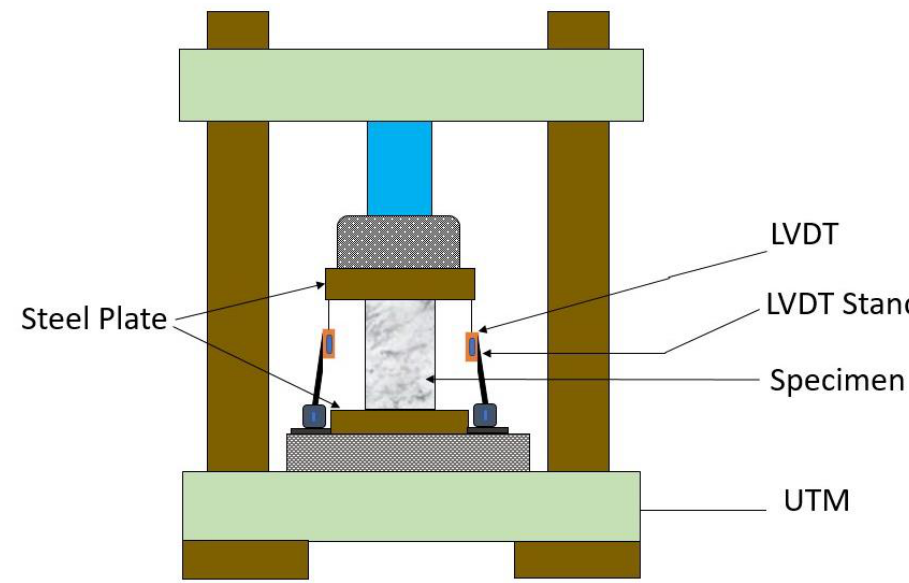
Figure 3. Test setup and instrumentation.